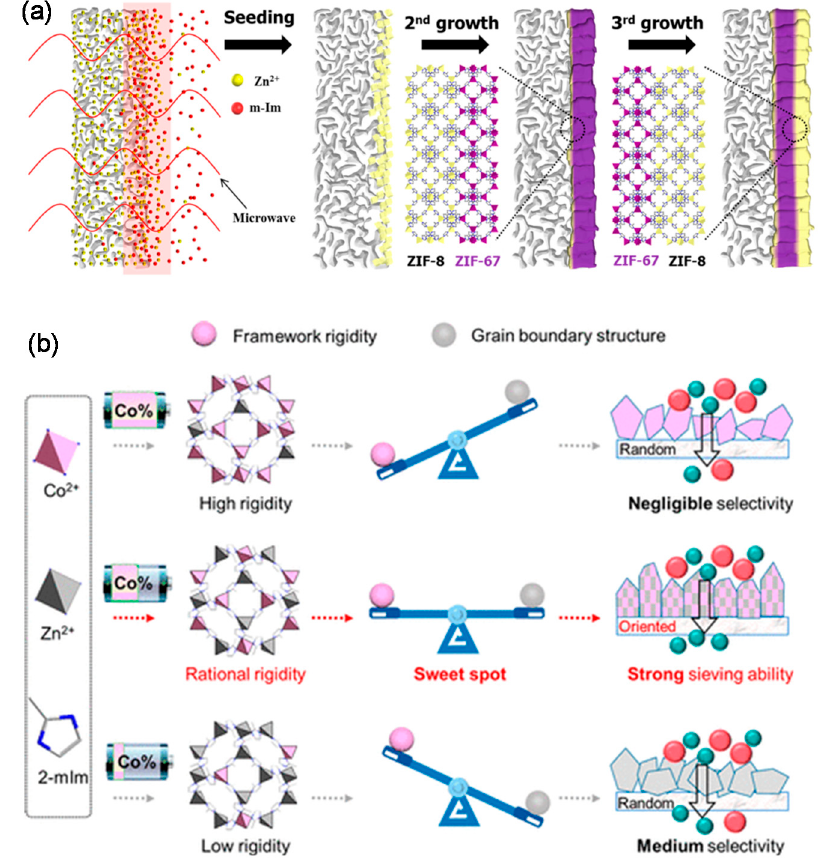
Figure 8. ( a ) Schematic illustration of the membrane synthesis via heteroepitaxial growth [76]. ( b ) Schematic illustration of the design of bimetallic Zn (100-x) Co x ZIF membranes [68].